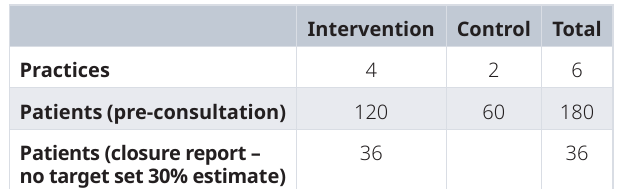
Table 2. Patient recruitment target in control and intervention